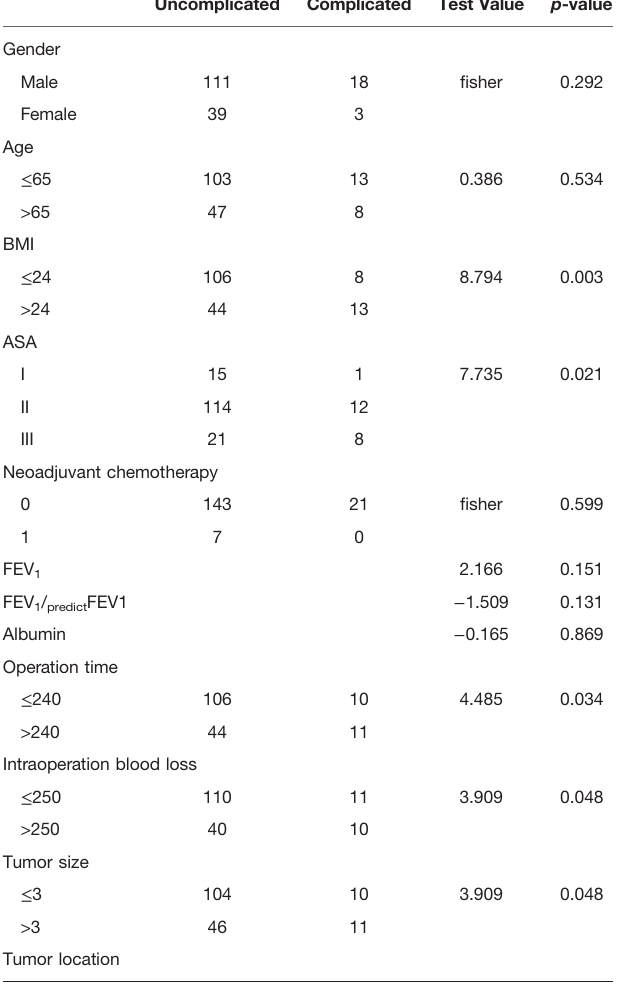
TABLE 1 | Relationship between preoperative neutrophil to lymphocyte ratio and clinicopathological characteristics in patients undergoing esophagectomy for esophageal cancer ( n =171).